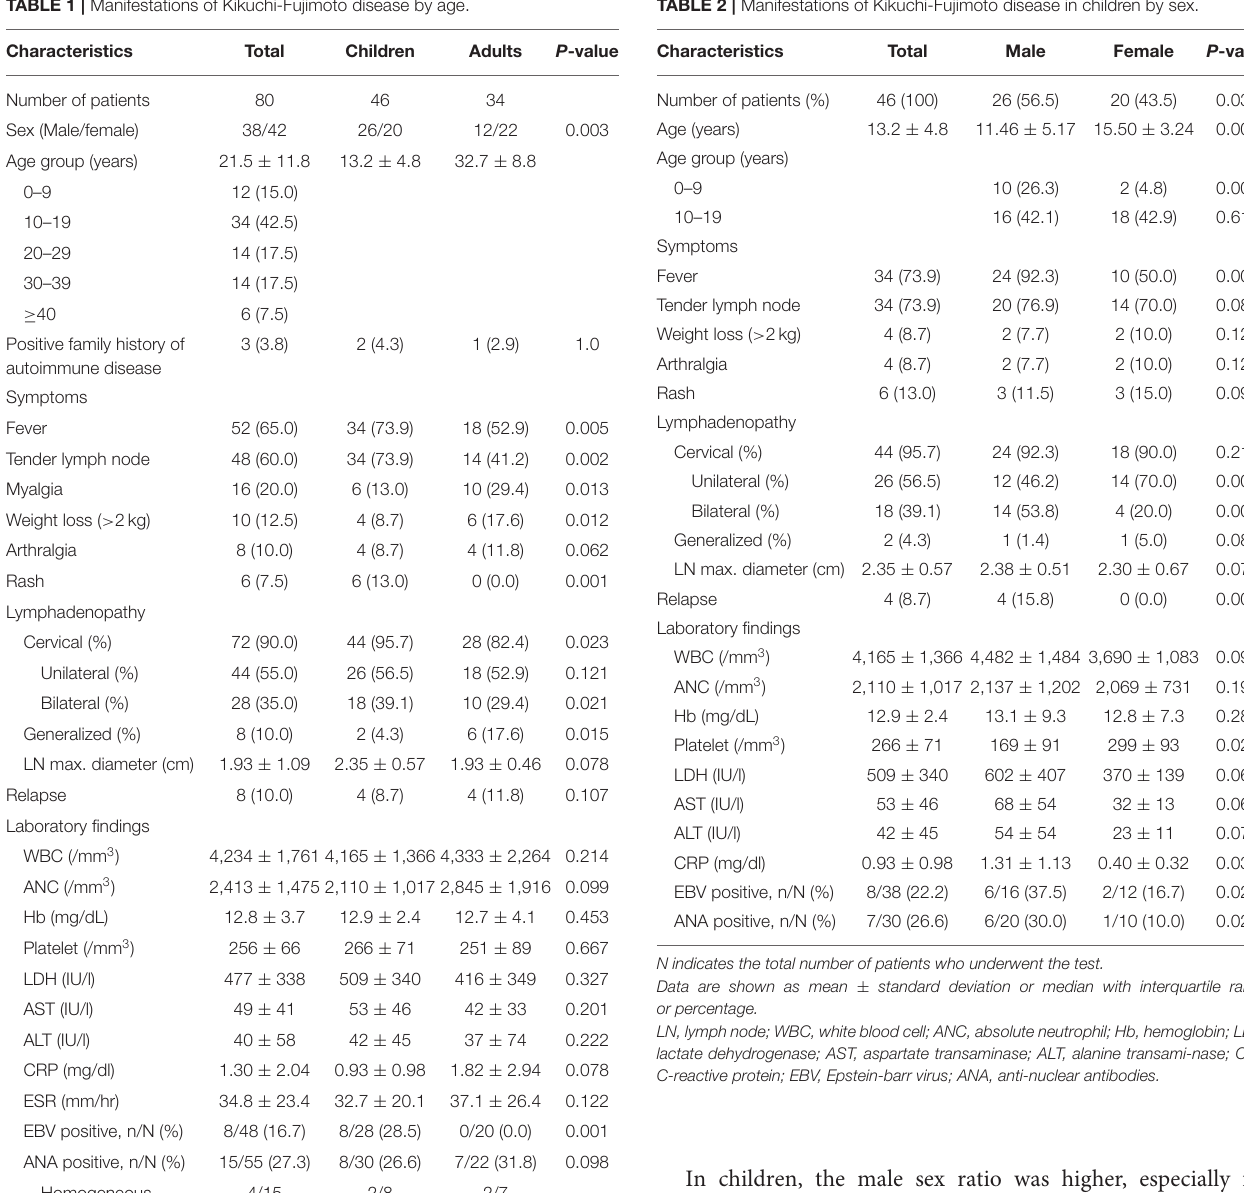
TABLE 1 | Manifestations of Kikuchi-Fujimoto disease by age. Characteristics